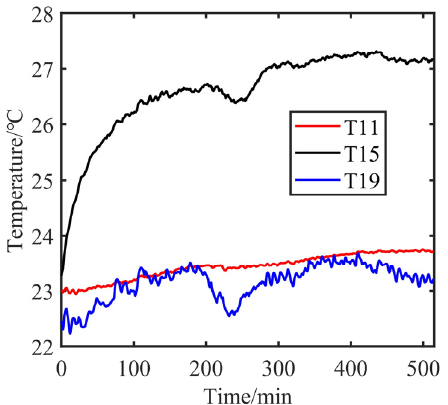
Figure 4. Temperature data of the selected key points for the first machine tool. The vertical machining center is thermally symmetrical in the X direction, so the thermal error in the X direction is relatively small. This paper only analyzes the thermal error in the Y and Z directions of the spindle. As can be seen from Figure 4, T11 (the upper headstock), T15 (motorized spindle), and T19 (workshop environment) are selected as the key temperature points for modeling. The temperature rises rapidly in the initial stage of machine operation and quickly reaches thermal equilibrium. There was a significant difference in the temperature between the headstock and the spindle over time, which produced an uneven temperature field and thermal deformation. The experiment was carried out in the temperature-rising stage for 500 min, and the error of the Y direction and Z direction reached 4.45 µ m and 15.38 µ m, respectively. The multiple linear regression model was established between the temperature data of key temperature points and the axial thermal errors. Therefore, the final thermal error compensation model of the machine tool can be expressed as